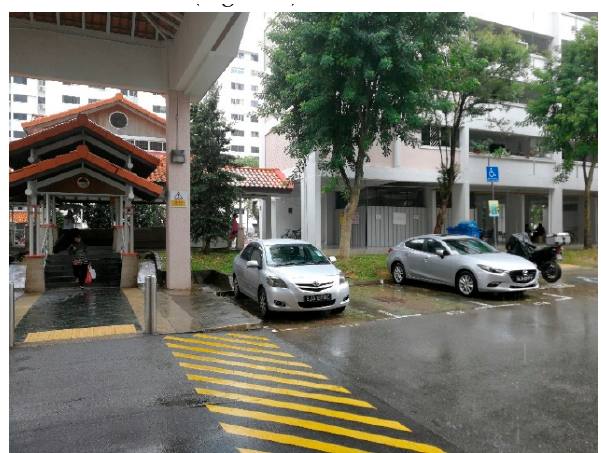
Figure 6. Sheltered stairs with an unsheltered slope nearby. Figure 7. Sheltered stairs with an unsheltered slope